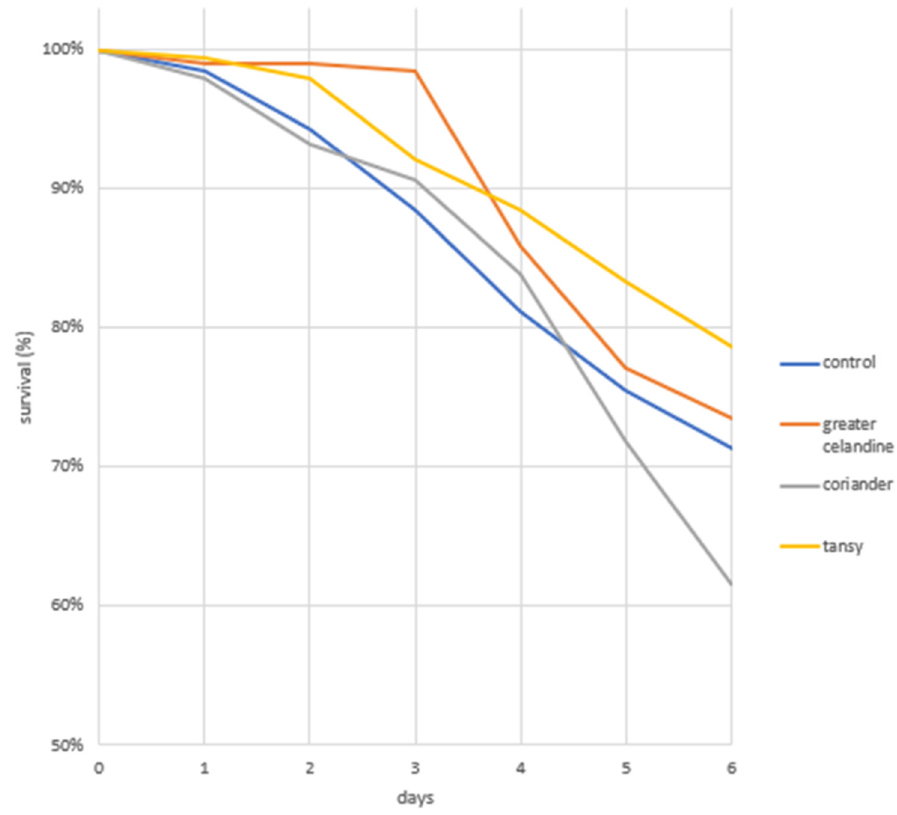
Figure 2. Percentage of survival of honey bee larvae reared in vitro and fed a control diet or diets containing plant infusions of coriander, greater celandine, and tansy.